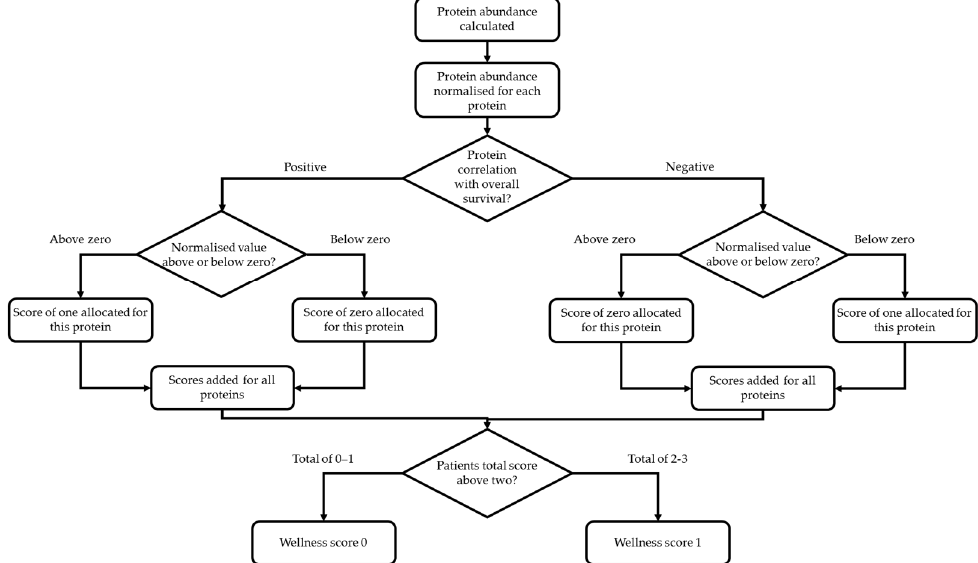
Figure 2. Decision tree for calculation of the Wellness Score for all patients. After protein abundances were calculated from mass spectrometry data, they were individually normalised. A zero value was provided to signify a decrease in the risk of death. If a normalised value of a positively correlated protein was above zero a value of one was given and a value of zero given if the normalised value was below zero. If a normalised value of a negatively correlated protein was above zero a value of zero was given and a value of one given if the normalised value was below zero. For each patient, their protein scores were summed together. The Wellness Score was categorised as 0 if they had a total summed protein score of 0–1 and a Wellness Score of 1 if they had a total summed protein score of 2–3.